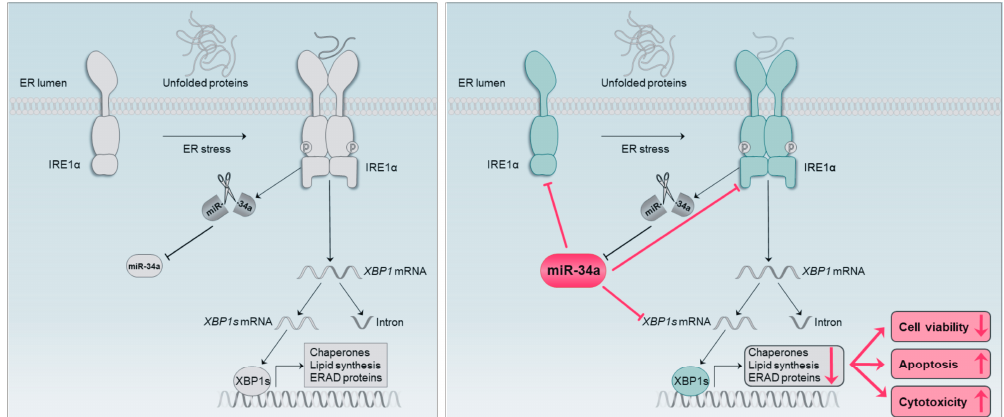
Figure 6. The hypothesized role of miR-34a-5p in the IRE1 α branch of UPR signaling. Left panel: the previously described interaction of miR-34a-5p and the IRE1 α branch. Right panel: novel findings